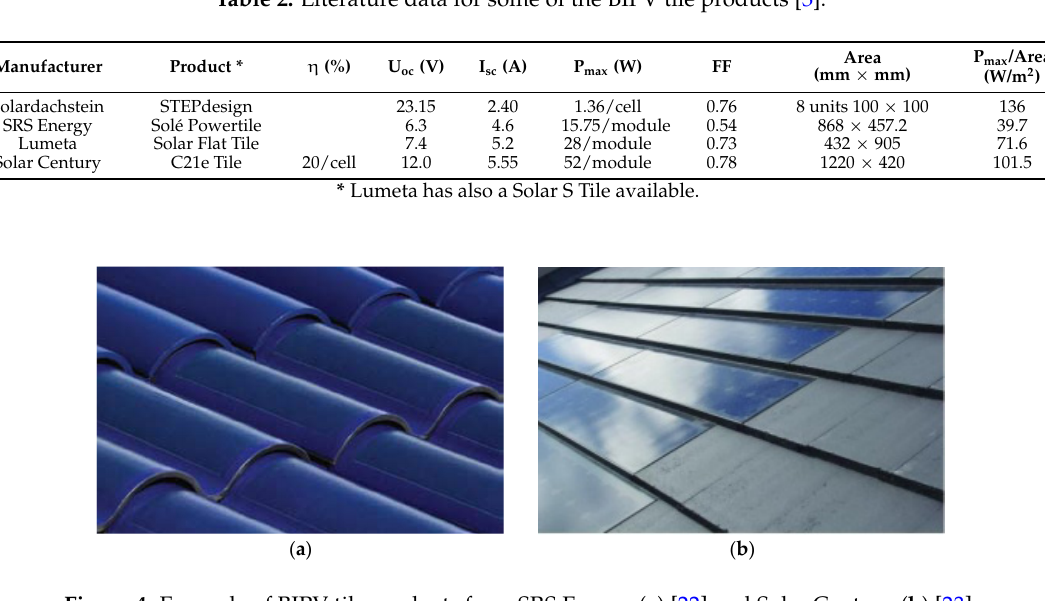
Figure 4. Example of BIPV tile products from SRS Energy ( a ) [22] and Solar Century ( b ) [23].